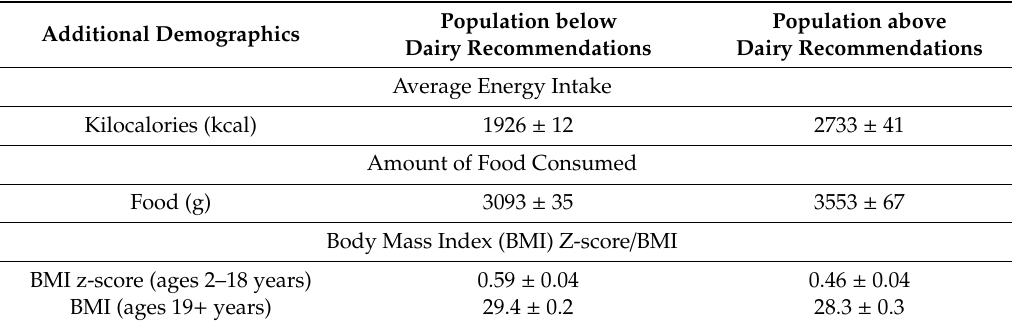
Table 3. Energy intake, grams of food intake, and Body Mass Index of U.S. population 2 + years consuming above recommended daily servings of dairy and those consuming fewer than the recommended daily servings of dairy in the National Health and Nutrition Examination Survey 2013–2016 1 .